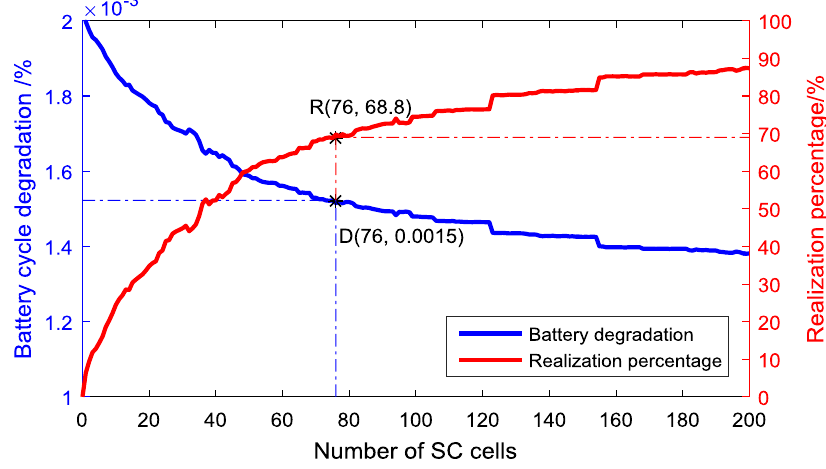
Figure 22. Battery degradation at different SC cells.